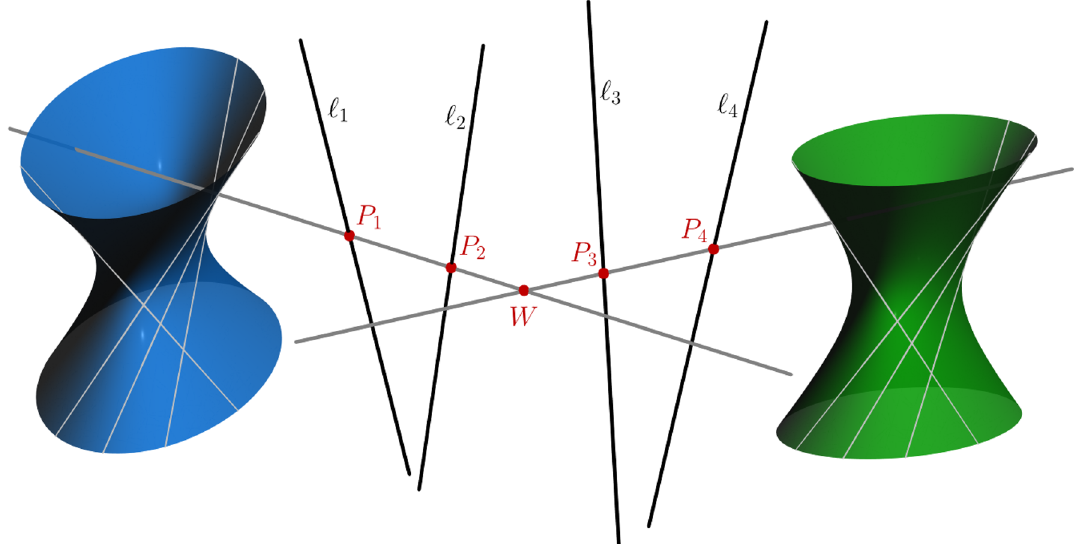
Figure 5 . Quadrics and lines de(cid:12)ning the CY three-fold in the four-loop traintrack diagram. The last condition forces the two transversals P (cid:12)gure